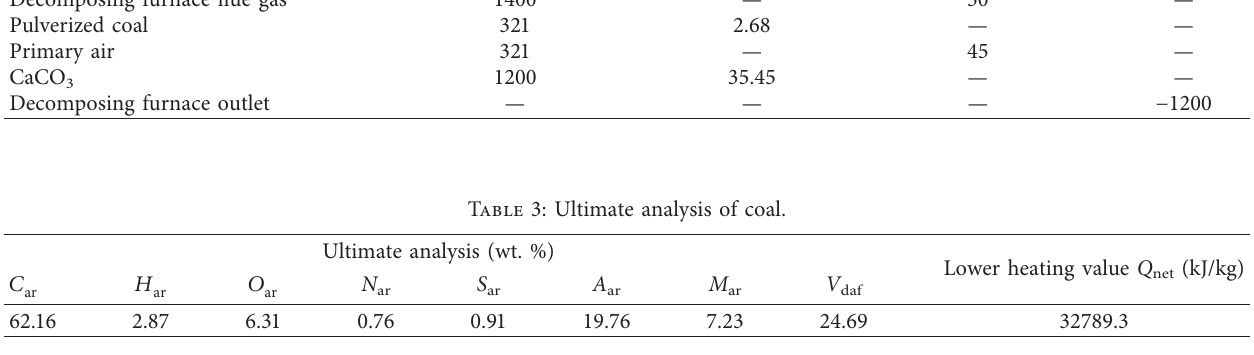
x and limestone.